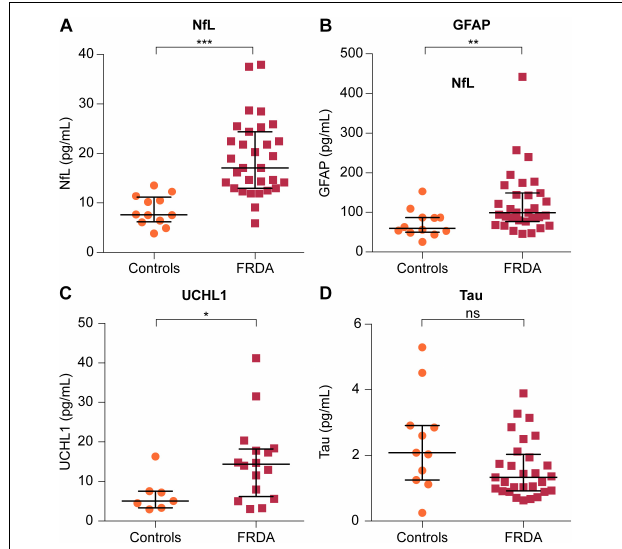
FIGURE 2 | Comparison of plasma levels of four brain-derived proteins between FRDA patients and controls. Plasma concentrations of (A) NfL, (B) GFAP, and (C) ubiquitin C-terminal hydrolase L1 (UCHL1) are significantly increased in FRDA compared to age-matched controls. (D) Plasma tau levels were lower in FRDA patients, although this did not reach statistical significance. The horizontal bars indicate the median with error bars denoting the interquartile range. ∗ p < 0.05, ∗∗ p < 0.01, and ∗∗∗ p < 0.001.